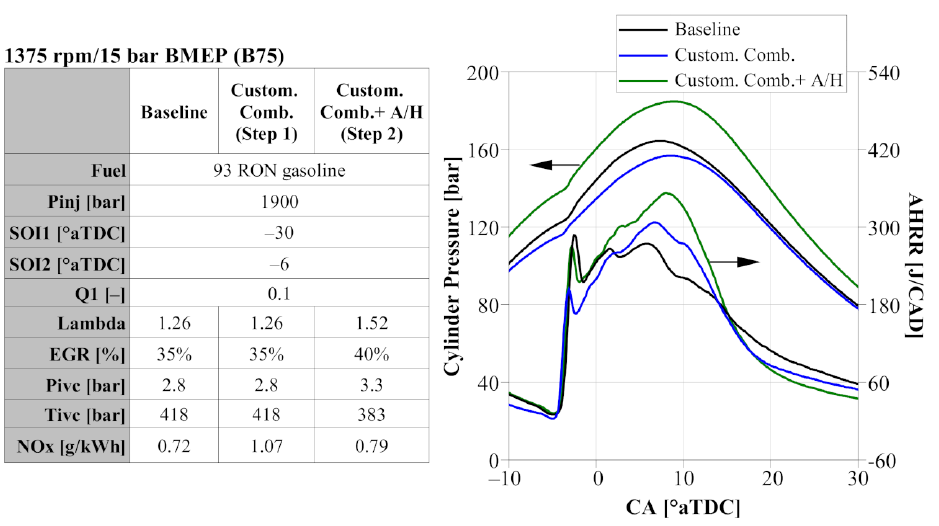
Figure 11. Step-wise simulation boundary conditions and global combustion behavior for the customized combustion and A/H system concept at